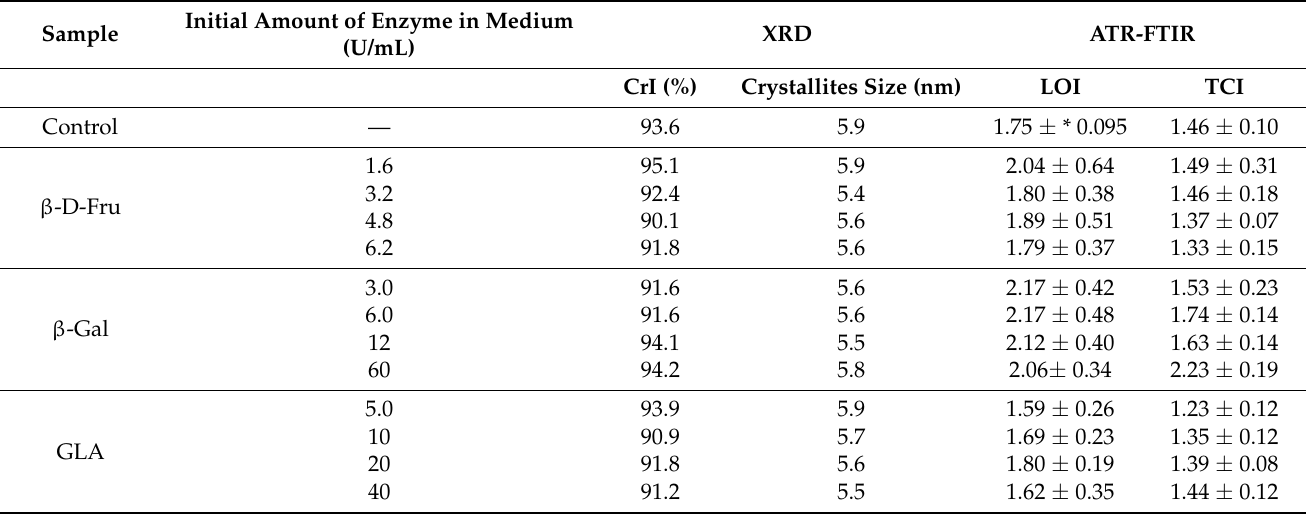
Table 2. The crystallinity degree and crystallite size, LOI, and TCI index values for BC obtained from different variants of K. xylinus cultures.